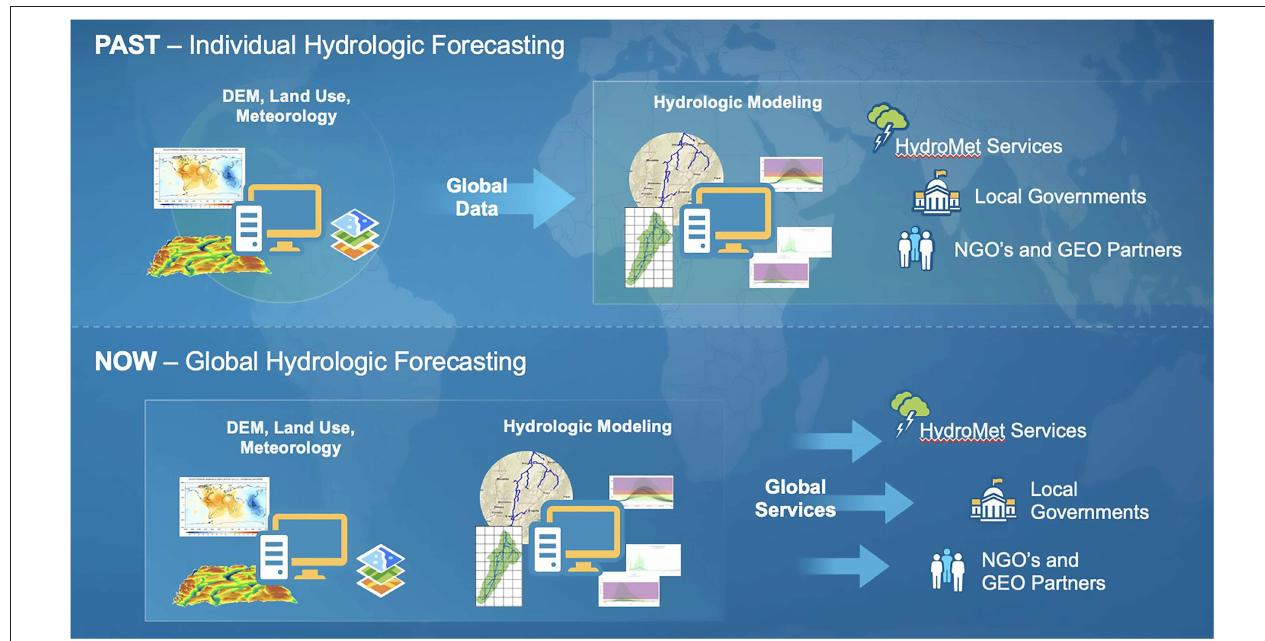
FIGURE 3 | Disruptive technologies for hydrologic information